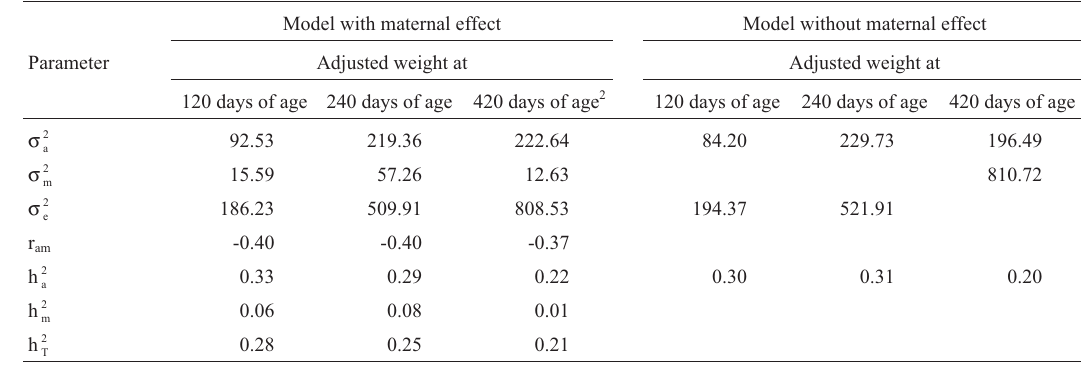
Table 4 - Estimates of additive direct ( σ a2 ), maternal ( σ m2 ) and residual (σ e2 )variances, direct maternal genetic correlations (r (h m2 ) and total (h T2 ) heritabilities obtained by multiple trait analyses 1